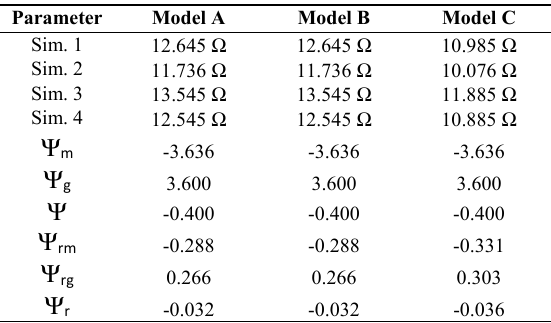
Tab. 2: Simulated impedances and associated perceptivities for the three models. Units for perceptivities are left out since we are considering change in phenomena which can be non-physical